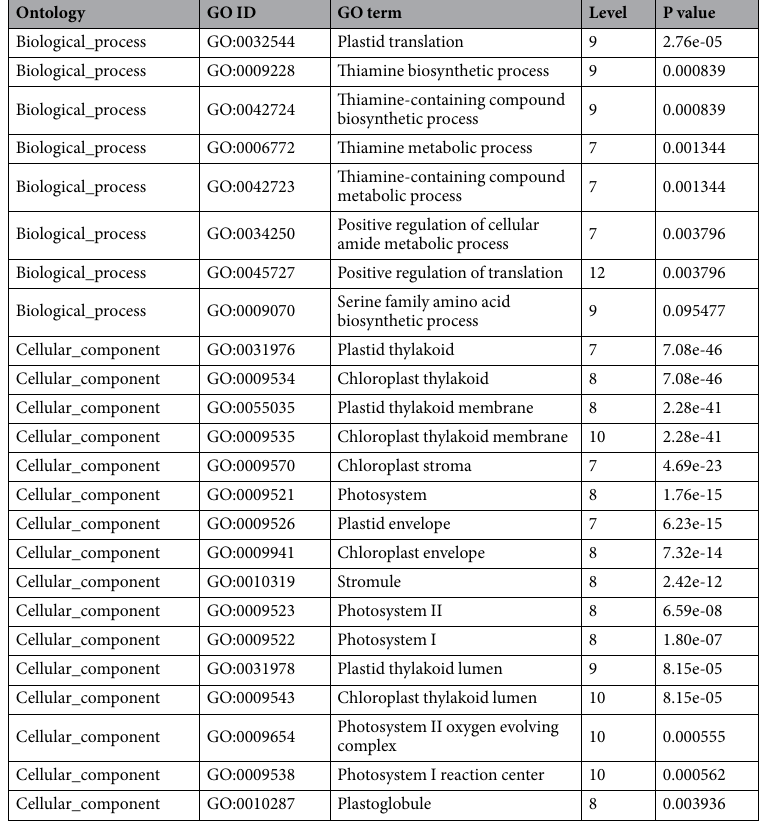
Table 2. Enriched GO terms in the down-regulated common genes between drought and heat stress condition, using the threshold of GO term level ≥